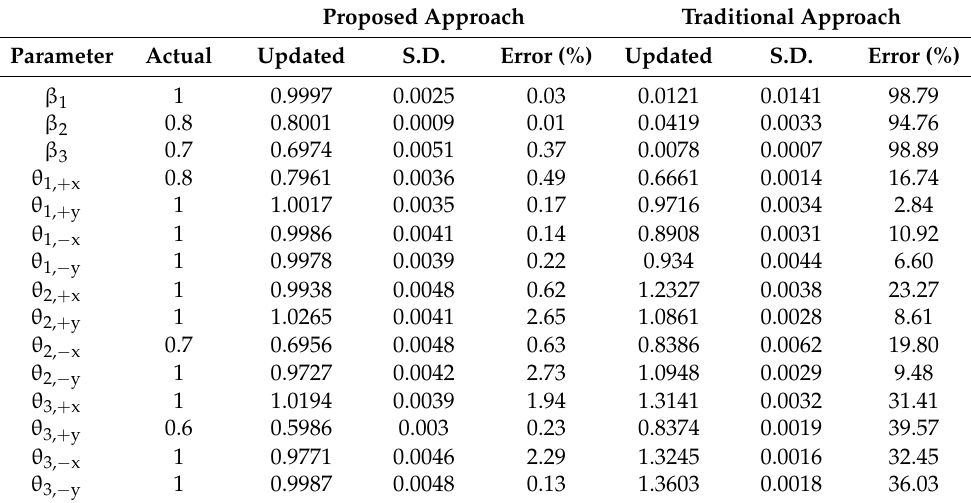
Table 11. Results of updated structural parameters for damage case No.